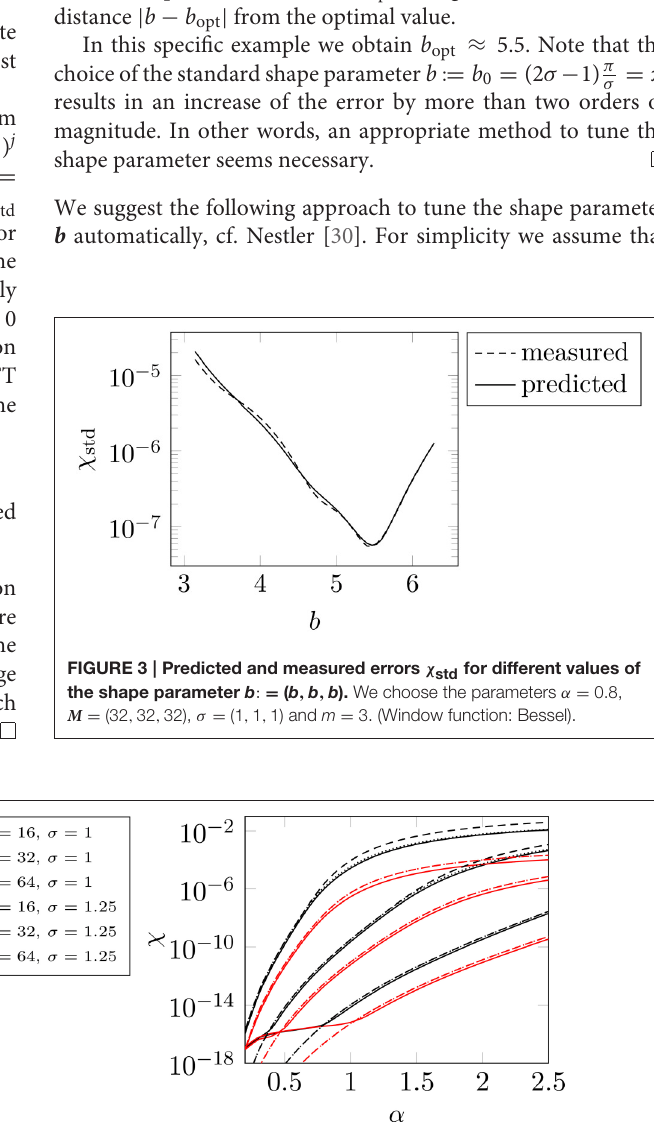
(see legend). The 1 , 1.25 ∈ { }